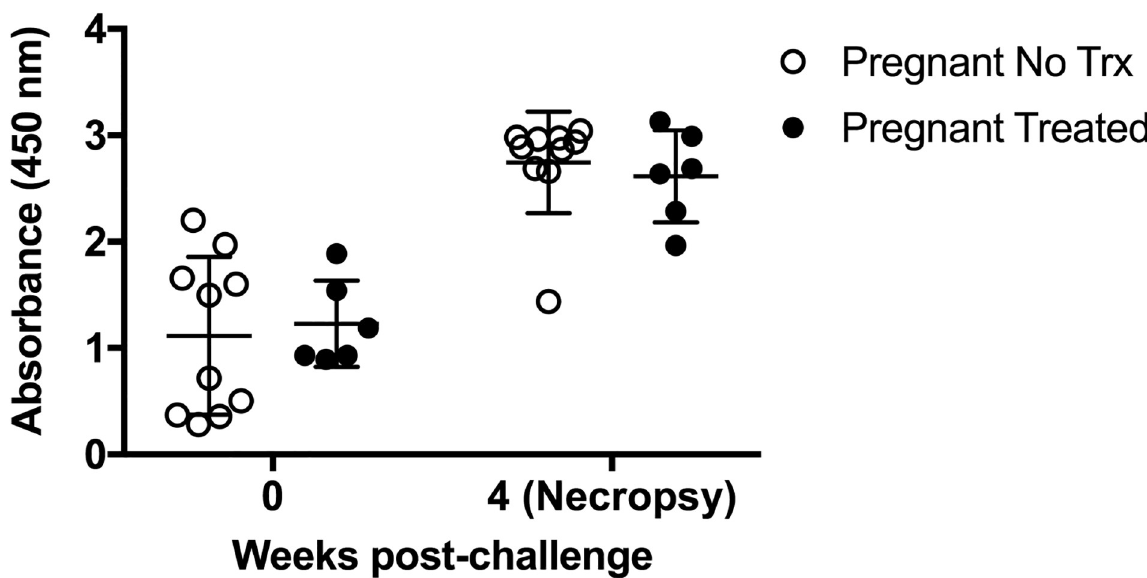
Fig 2. Antigen-specific IgG responses of pregnant goats following B . melitensis 16M challenge. Shown are IgG titers prior to and at 4 weeks post-challenge in pregnant goats either treated (black circles) or not treated (open circles) with